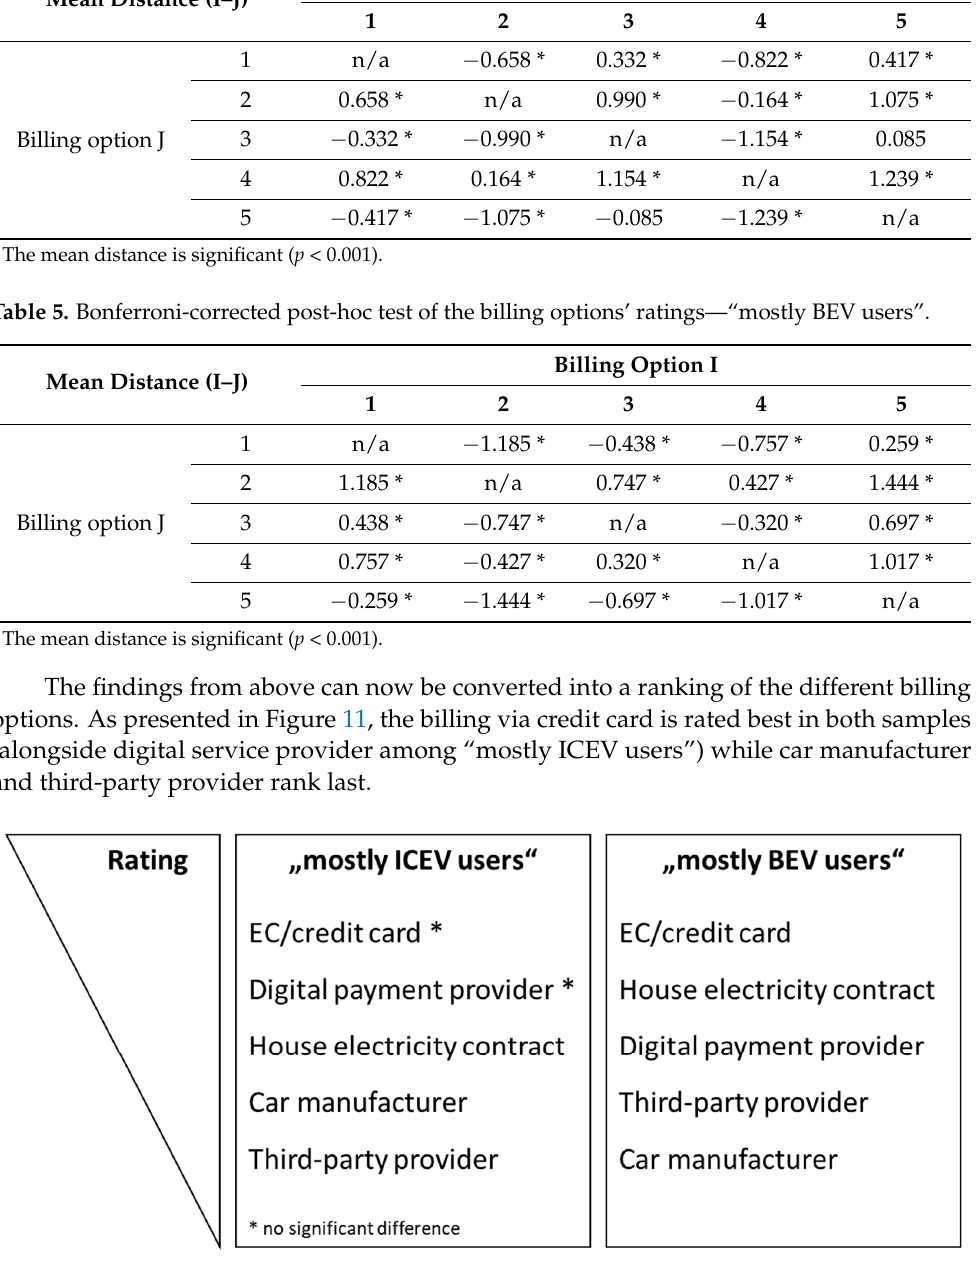
Table 4. Bonferroni-corrected post-hoc test of the billing options’ ratings—“mostly ICEV users”. Mean Distance (I–J)